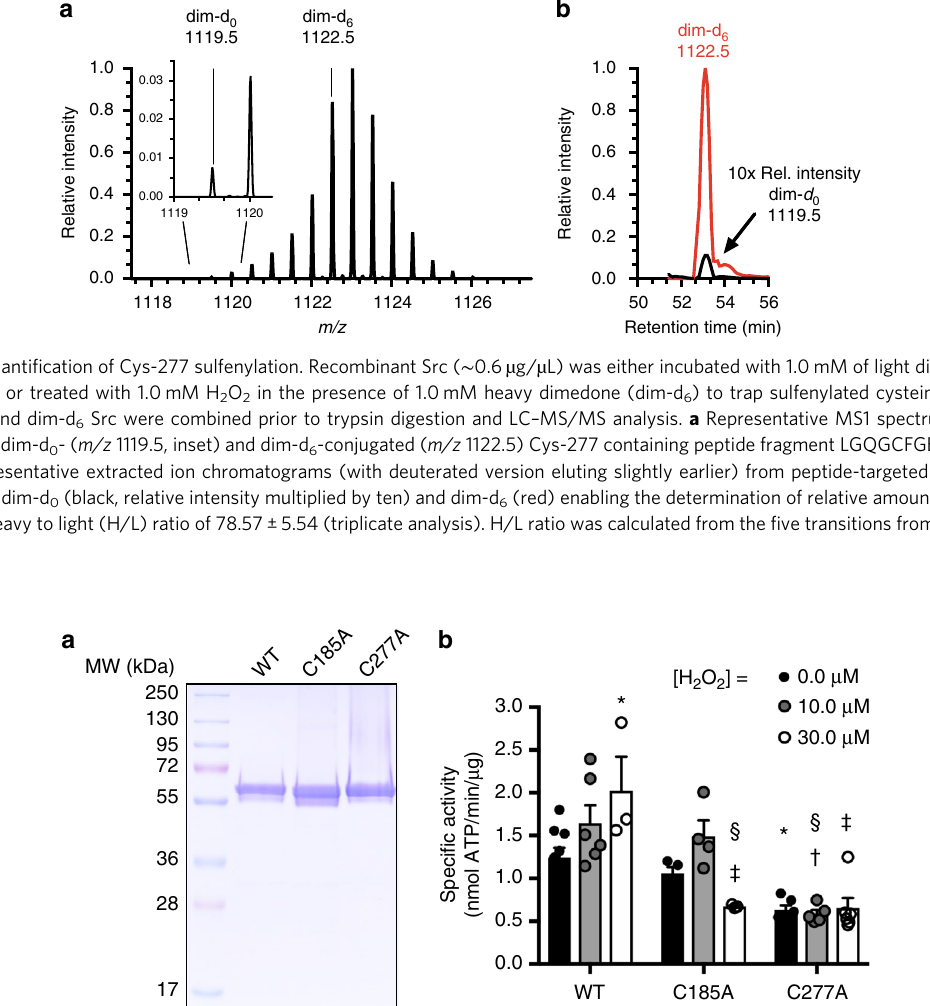
Fig. 2 H 2 O 2 enhances Src kinase activity depending on Cys-185 and Cys-277. a Coomassie-stained SDS-PAGE gel of 5 ng of WT, C185A, and C277A recombinant Src. b Analysis of kinase activity of recombinant Src variants following H 2 O 2 treatment measured with ADP Glo kinase activity kit. Data are expressed as means ± s.e.m. of at least three replicates from three independent experiments. Analyzed with two-way ANOVA where * p < 0.01 compared to WT [H 2 O 2 ] = 0 µ M; ‡ p < 0.0001 compared to WT [H 2 O 2 ] = 30 µ M; † p < 0.0001 compared to WT [H 2 O 2 ] = 10 µ M; § p < 0.005 compared to